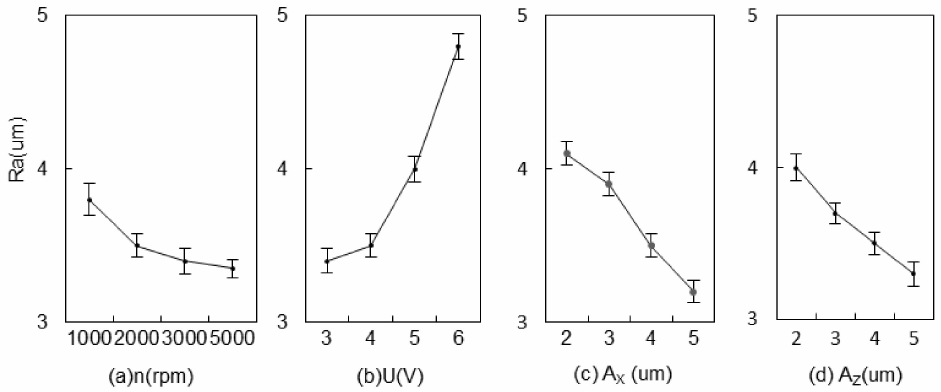
Figure 12. Effects of machining parameters on